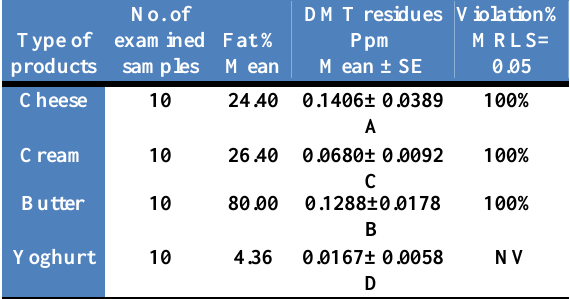
Table, 1: Comparison of the mean levels of DMT residues between different imported dairy products during the summer season.